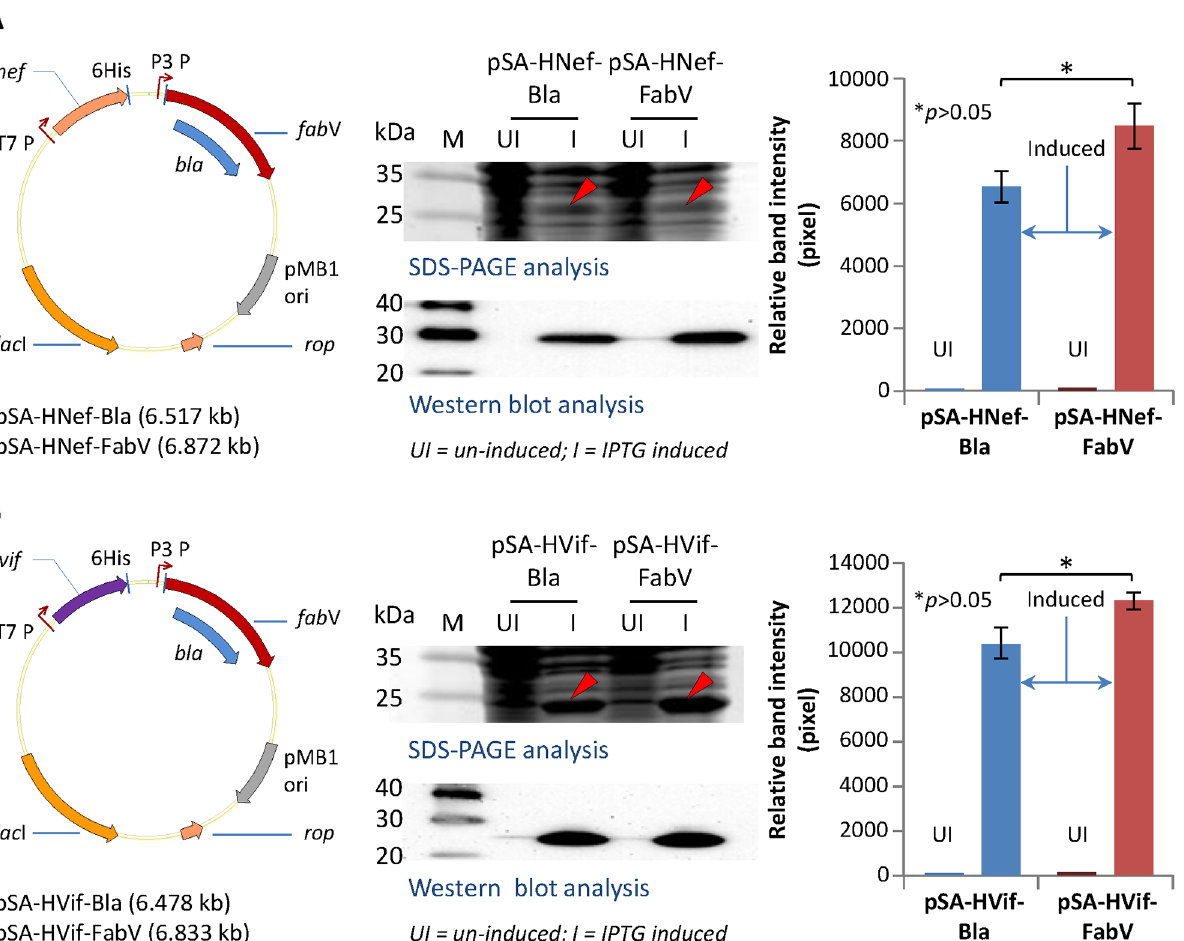
Fig 4. Expression of other heterologous recombinant proteins. BL21(DE3) cells were transformed with pSA-Nef/Vif-Bla or pSA-Nef/Vif-FabV plasmids and cultured in LB broth supplemented with either 269 μ M (100 μ g mL -1 ) Ampicillin or 1 μ M Triclosan respectively. Protein expression was induced with 50 μ M IPTG when cultures reached to 0.5 OD600. Induced and uninduced cultures were grown at 30°C for 6 hours and then analyzed by SDS-PAGE, western blot, and densitometry for the expression of recombinant Nef (A) and Vif (B) proteins. Error bars show standard deviations calculated from at-least three independent experiments each performed in